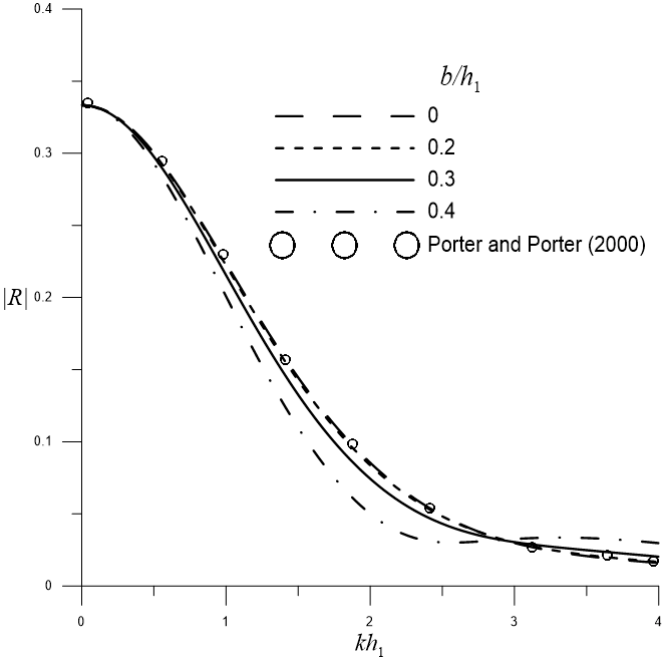
Figure 10. Reflection coefficient | R | varying against kh 1 for a single bottom-standing barrier of different barrier lengths.